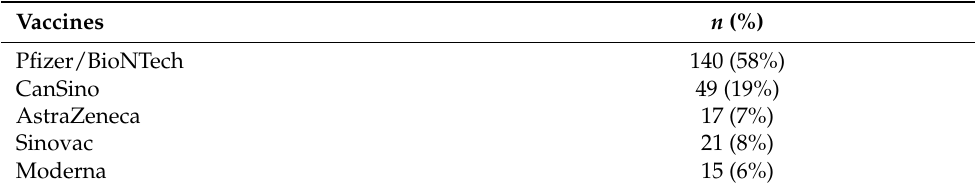
Table 2. Vaccine distribution.